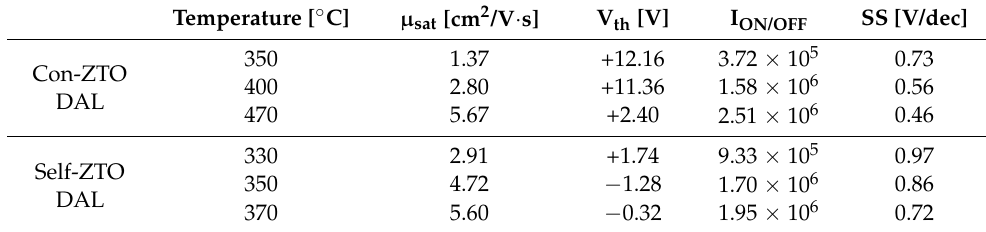
Figure 2. Transfer curves of ( a ) con-ZTO, and ( b ) self-ZTO DAL TFTs at various annealing temperatures. Table 1. Electrical parameters of two TFT devices according to the annealing temperature.